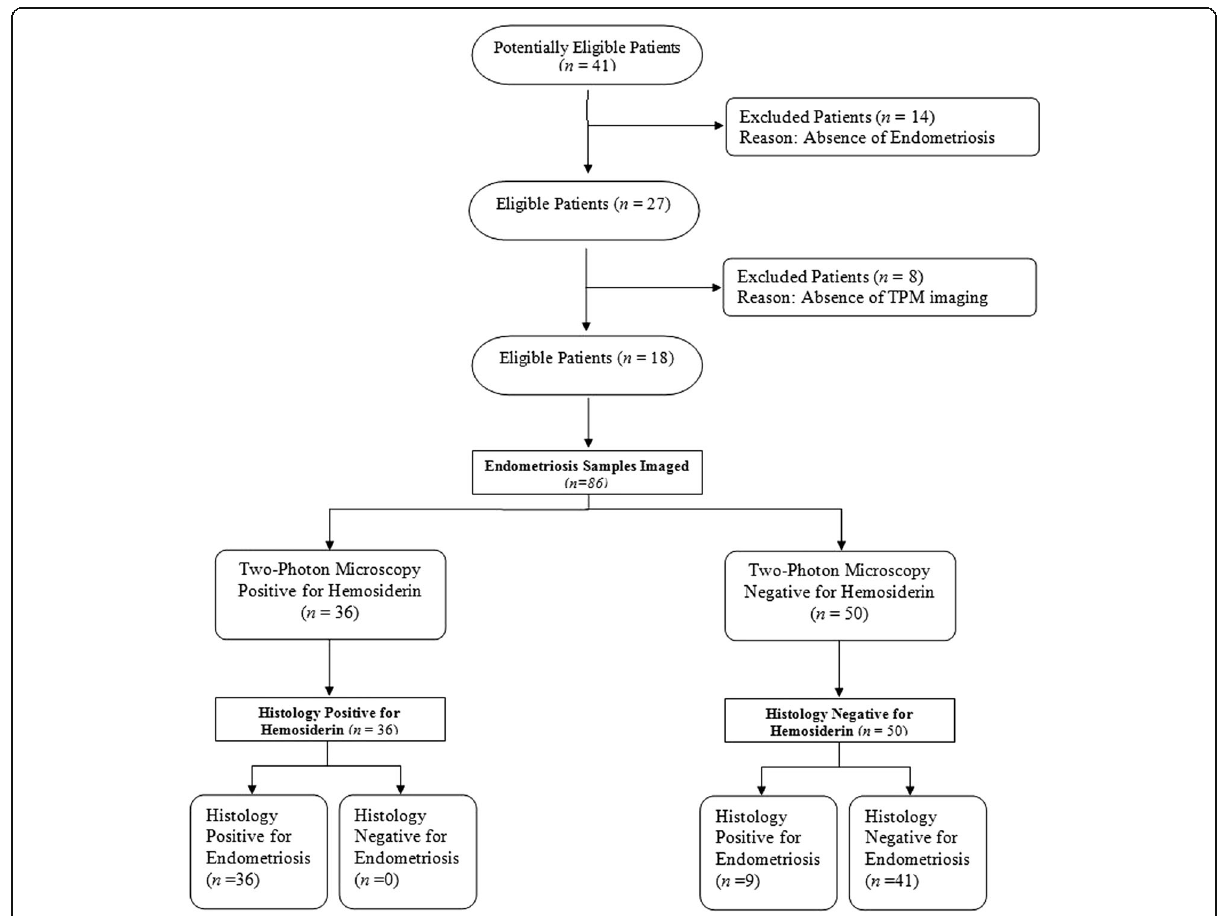
Fig. 2 Endogenous Fluorescence of Hemosiderin to Improve Clinical Detection of Endometriosis. Two-Photon Microscopy (TPM), Histology positive/negative for endometriosis based on pathologist ’ s determination of glands, stroma, and/or